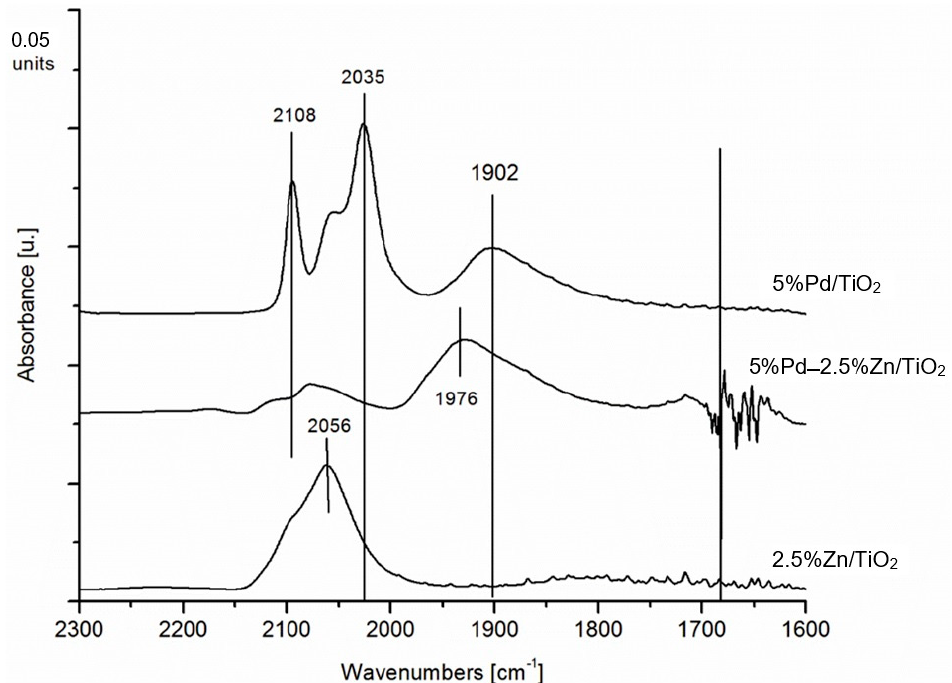
Figure 6. FTIR spectra of carbon monoxide adsorbed on bimetallic and monometallic catalysts after CO sorption at 40 °C with flow of 10 mL·min − 1 . The IR spectra were collected at the same temperature after CO desorption under an Ar stream (30 mL·min − 1 ) for 20 min.